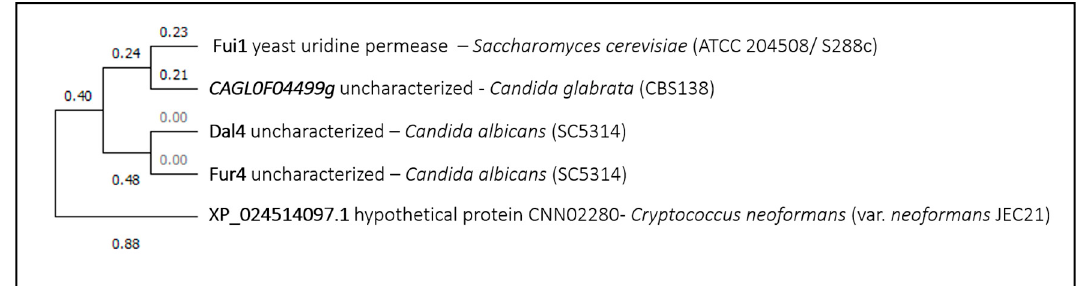
Figure 5. Fui1 phylogenetic analysis. The tree with the highest log likelihood is shown. This analysis involved five amino acid sequences. There were a total of 675 positions in the final dataset. Evolutionary analyses were conducted in MEGA X.